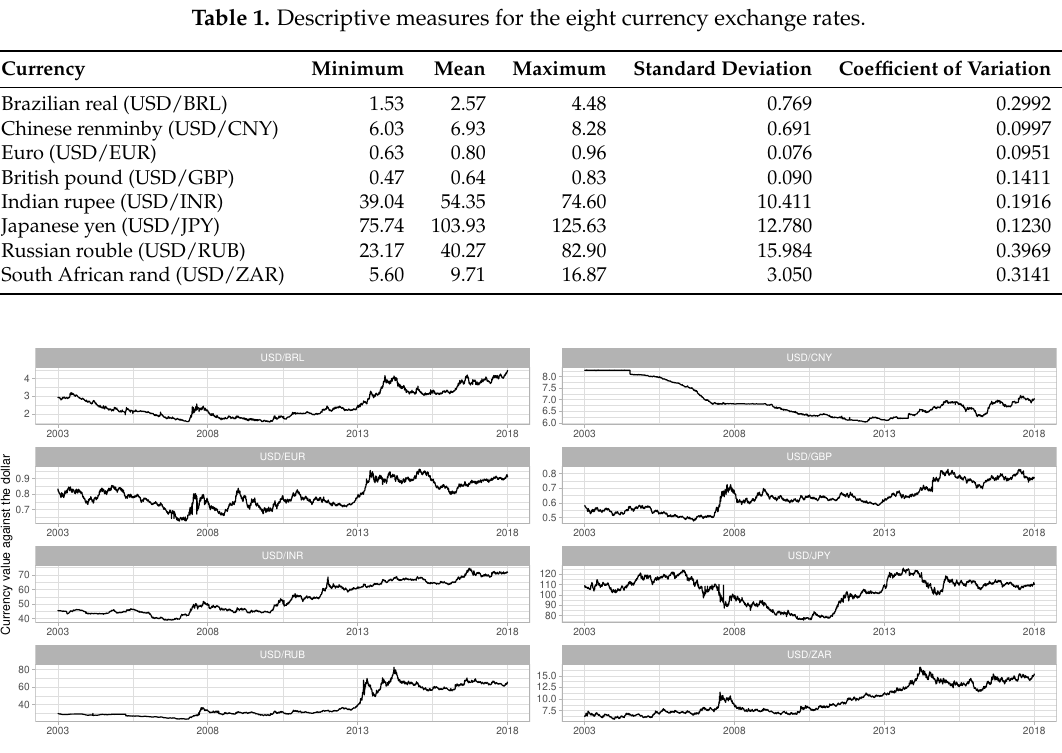
Figure 2. Time series for the exchange rates of the eight currencies against the USD. From top to bottom and from left to right: USD/BRL, USD/CNY, USD/EUR, USD/GBP, USD/INR, USD/JPY, USD/RUB and USD/ZAR. The vertical axes show the exchange rate and the horizontal axes shows the